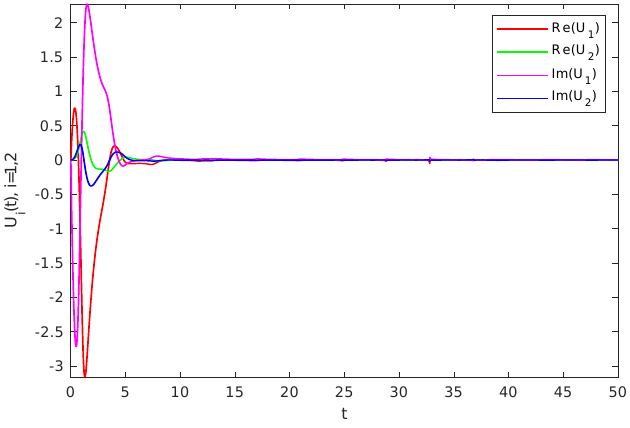
Figure 13. Synchronization between x 2 ( t ) and y 2 ( t ) under the adaptive controller (23).